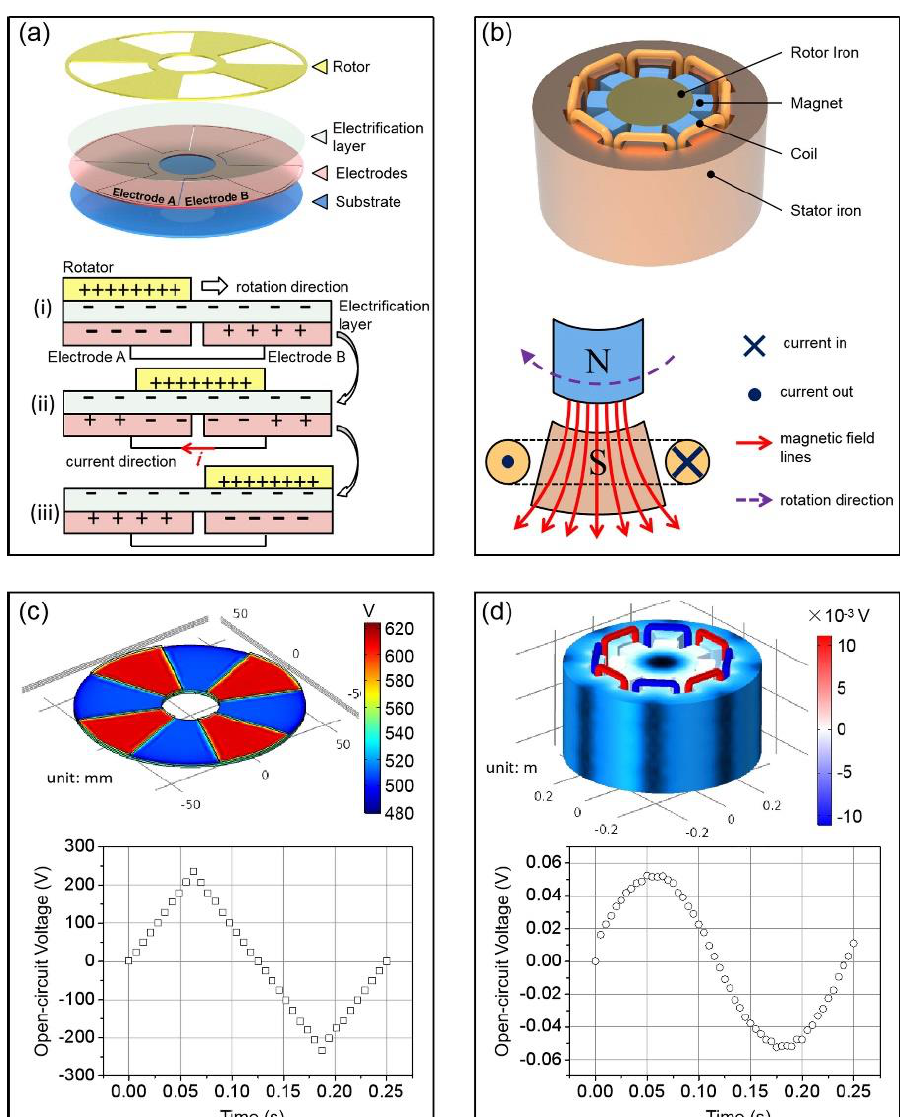
Figure 2. The structural design and COMSOL simulation results of the pr − TENG and EMG. ( a ) Schematic sketch and working mechanism of the pr − TENG; ( b ) schematic sketch and working mechanism of the EMG; ( c ) electrical output of the pr − TENG by COMSOL simulation; ( d ) electrical output of the EMG by COMSOL simulation.